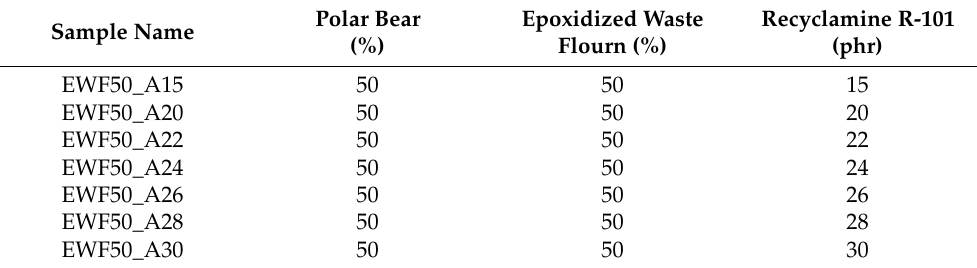
Table 2. Samples at constant commercial/epoxidized waste flour ratio and varying amine